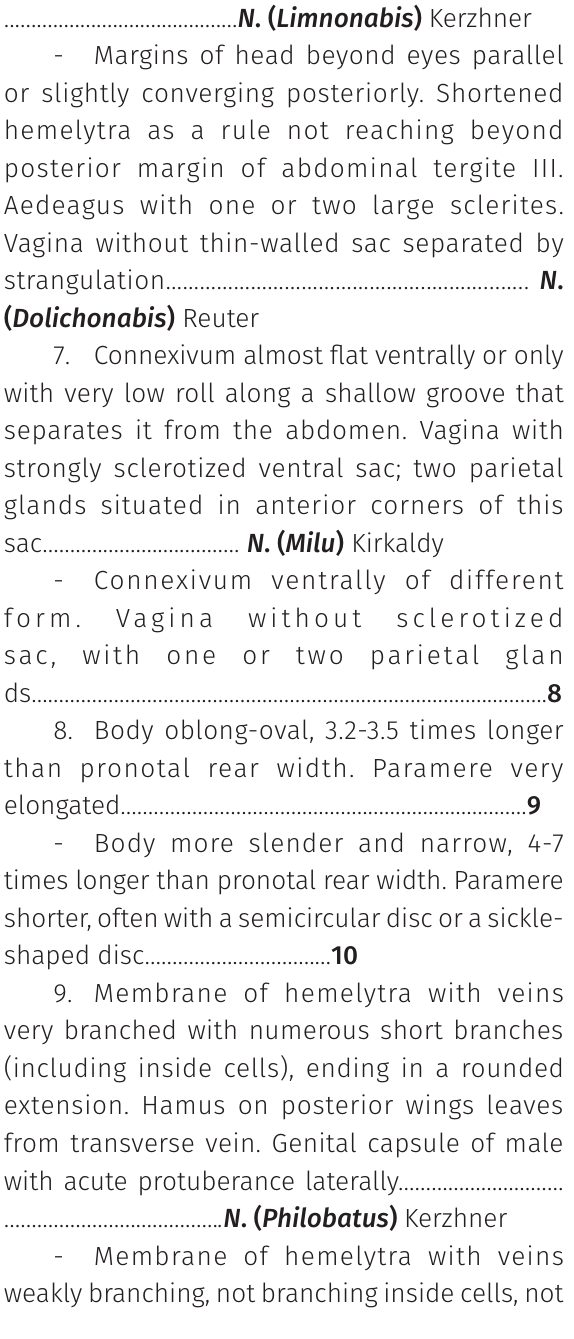
- Membrane of hemelytra with veins weakly branching, not branching inside cells,